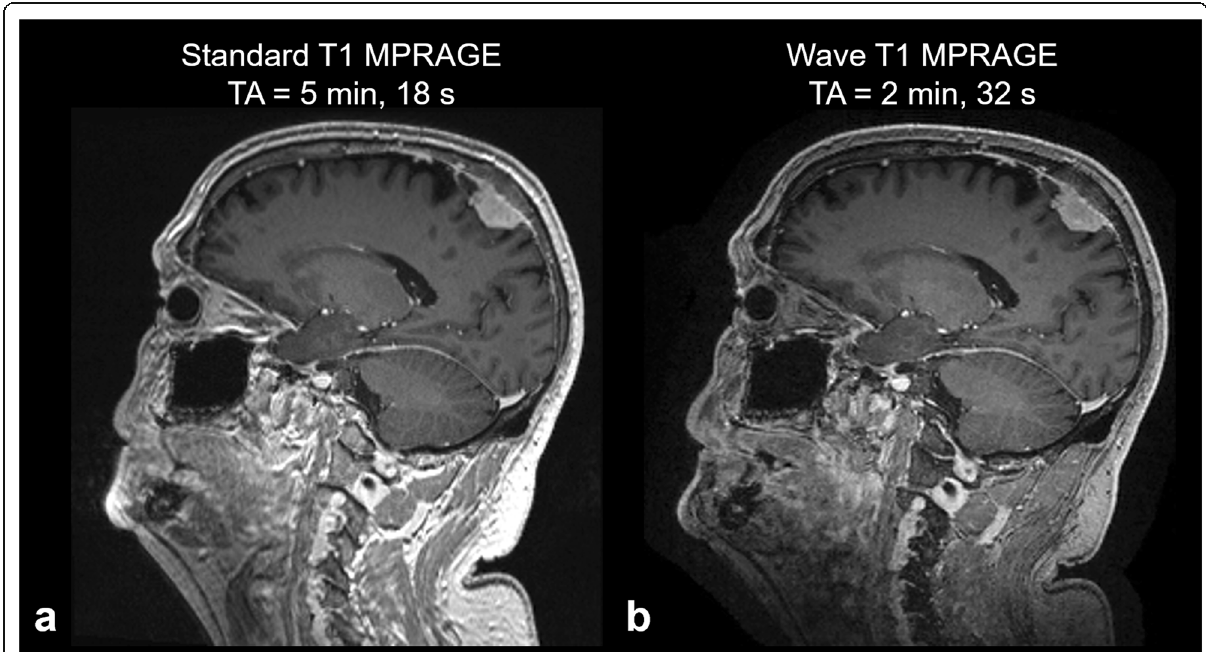
Fig. 7 Comparison of post-contrast three-dimensional T1-weighted magnetization prepared rapid acquisition gradient recalled echo (MPRAGE) images acquired with conventional parallel imaging and wave-controlled aliasing in parallel imaging (CAIPI) encoding demonstrating a meningioma. Standard ( a ) and Wave-CAIPI ( b ) T1-weighted MPRAGE images show equivalent visualization of the dural-based enhancing mass along the parietal convexity. Both images were acquired on a 3-T Siemens Prisma MRI scanner equipped with 80 mT/m maximum gradient strength and 200 T/m/s maximum slew rate. The Wave-CAIPI sequence was more than twice as fast as the standard sequence (acquisition time = 2 min, 32 s for Wave-CAIPI compared to 5 min, 18 s for the standard